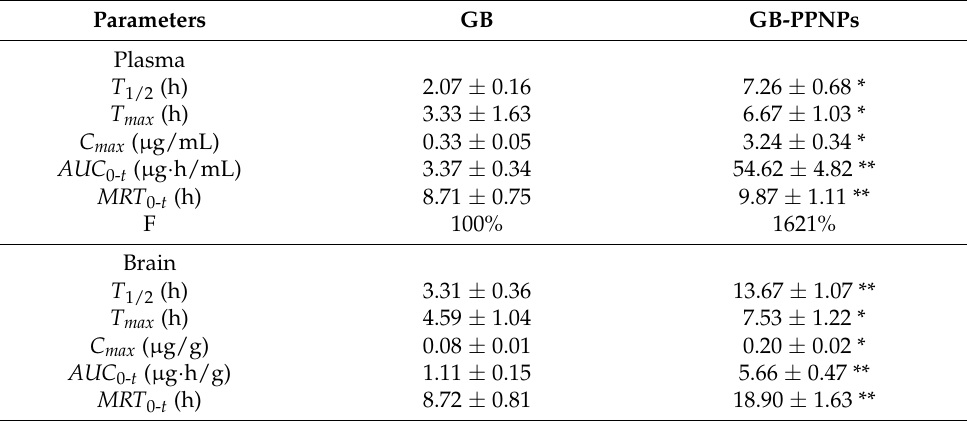
Figure 5. In vivo analysis of GB-PPNP pharmacokinetics. ( A ) Plasma curve ( n = 7). ( B ) Brain curve ( n = 4). Table 1. Plasma and brain pharmacokinetic parameters of GB-PPNPs following oral administration ( n = 7 or 4). Significant differences between free GB and GB-PPNPs are marked with * for p < 0.05 and ** for p < 0.01.